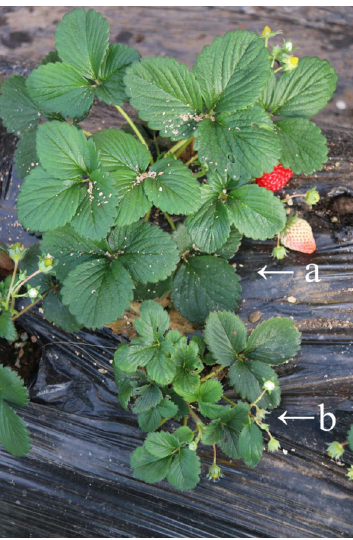
Figure 1. Symptoms of SVBV-infected strawberry plants in the field. ( a ) No obvious symptom; ( b ) Leaf mottle, stunted and clustered